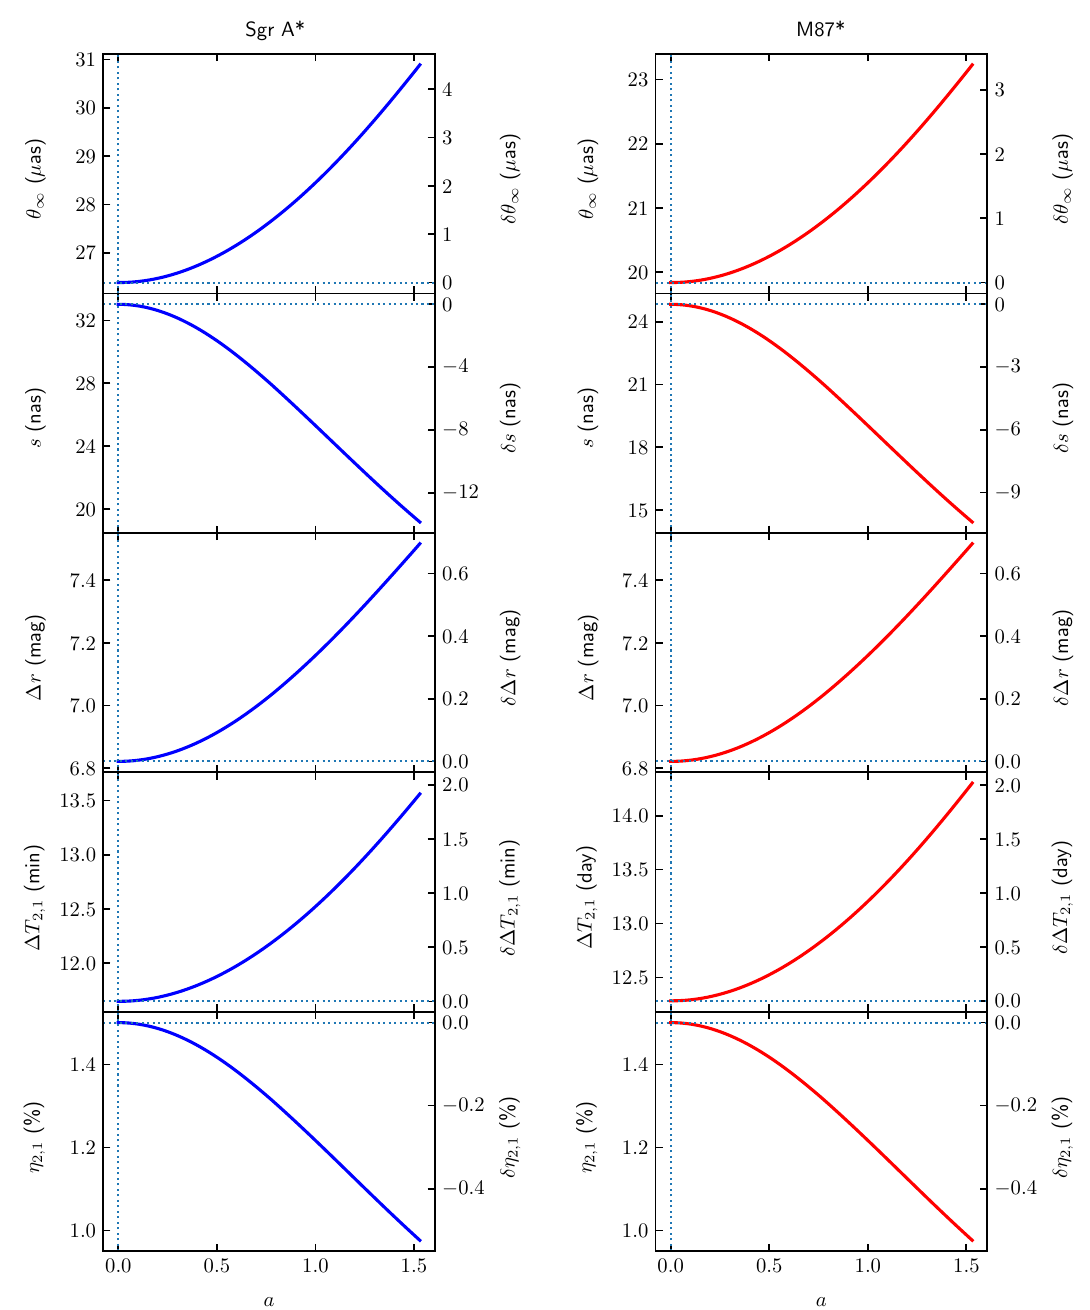
Fig. 4 The observables in the strong deflection gravitational lensing by the quantum deformed Schwarzschild black hole and their devia- tions from those of the Schwarzschild black hole are shown for Sgr A* (left panel) and M87* (right panel) on the domain D . From top to bottom, the angular radius of the shadow θ ∞ , the angular separation s